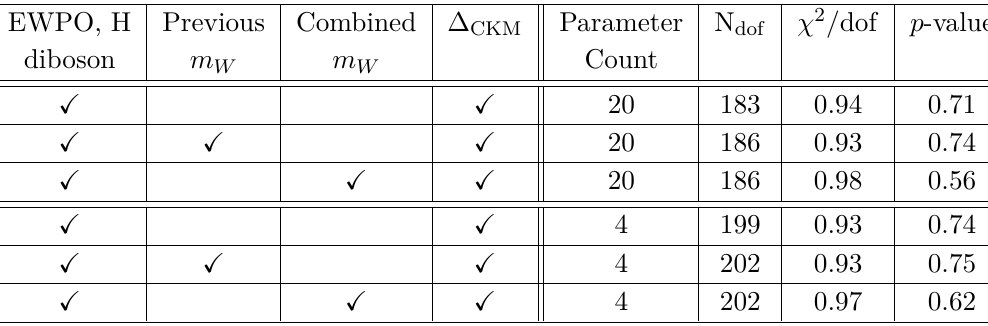
Table 7 . As table 6, but including also the ∆ CKM